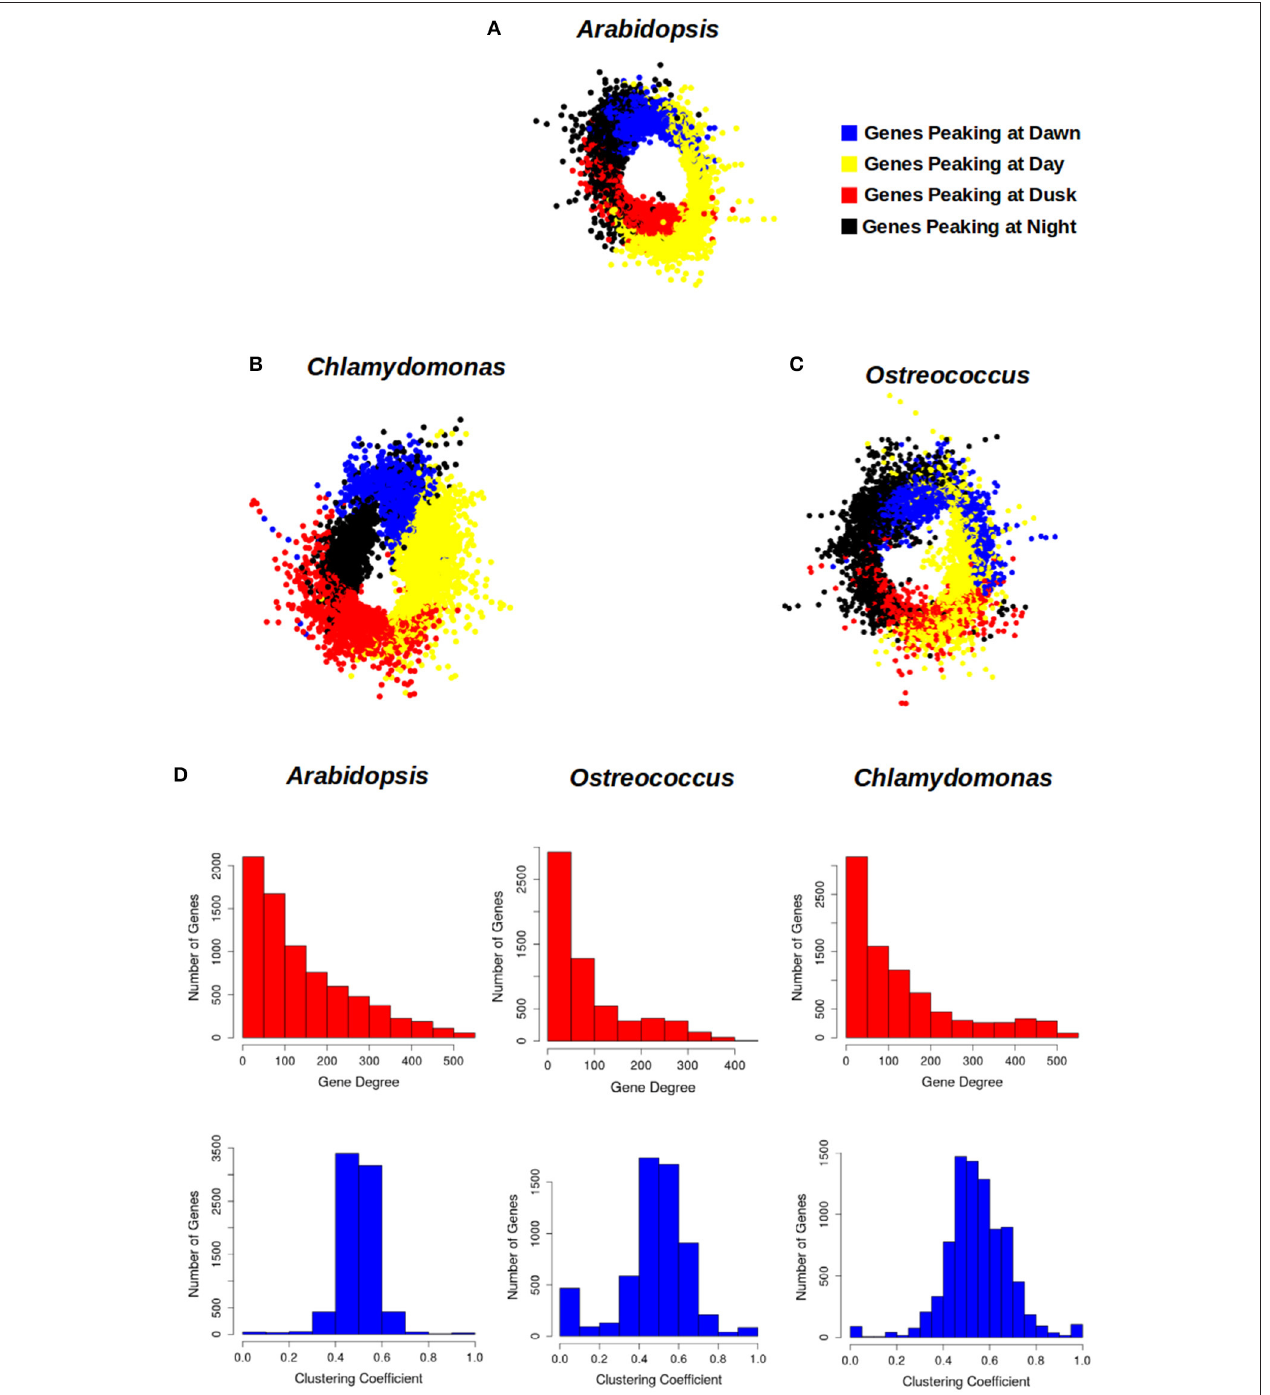
FIGURE 6 | Circadian gene co-expression networks. Genes are represented by nodes and edges represent co-expression between them (Pearson correlation index between their 24 h-expression profiles greater than 0.95). The three networks acquired a ring-like structure mirroring the periodic expression pattern of daily rhythmic genes. (A) Arabidopsis daily rhythmic gene co-expression network comprised 7639 circadian genes with 537027 co-expression relationships. (B) Chlamydomonas daily rhythmic gene co-expression network consisted of 10338 circadian genes and 573980 co-expression interactions. (C) Ostreococcus daily rhythmic gene co-expression network comprised 5782 nodes and 222493 co-expression relationships. (D) The topological analysis of the three gene co-expression network shows that they are scale-free and small-world networks: (1) Their degree distributions (above, red) follow an exponential negative distribution. (2) Their average clustering coefficient (below, blue) is significantly greater than random networks with equal number of nodes and edges. Gene cluster with a peak at Dawn is represented in blue, that with a peak during the Day in yellow, the one showing a peak at Dusk in red and that with a peak at Night in black.